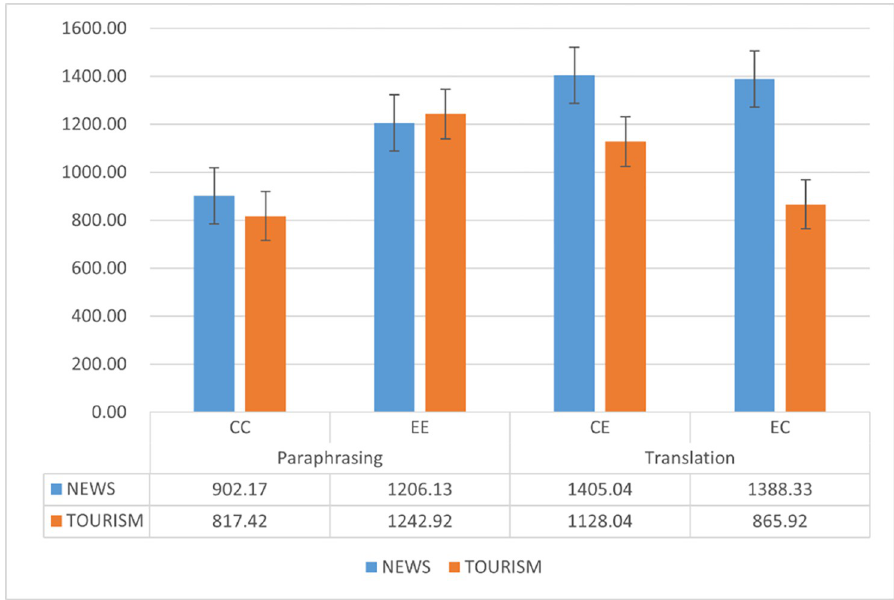
Fig 1. Total task time (s) for translation and paraphrasing in different